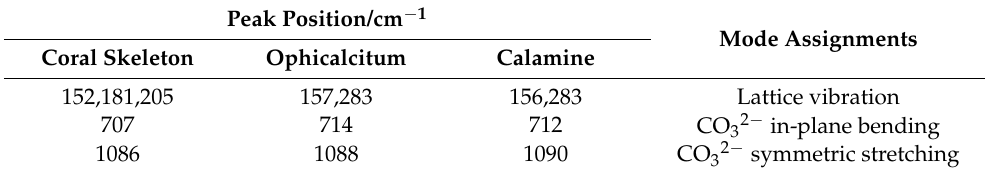
Figure 2. The Raman spectra of ( a ) coral skeleton, ( b ) ophicalcitum, and ( c ) calamine. Table 2. The characteristic peak assignment of the three carbonate mineral